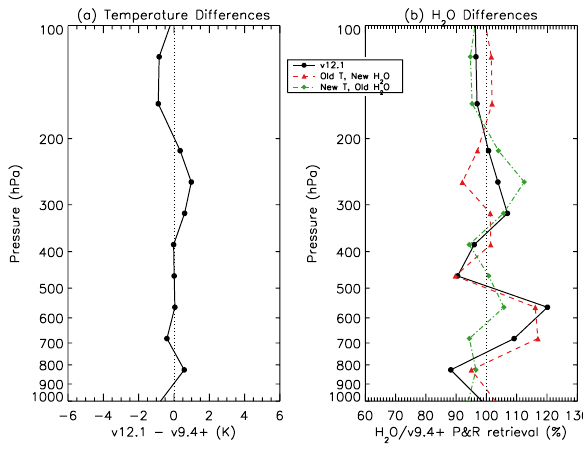
Fig. 21. Mean (black circles) and standard deviation (error bars) of the ratio of the 120 LBLRTM v12.1 retrieved H 2 O profiles to the v9.4 + retrieved profiles, expressed as a percent. Dashed lines show the mean differences for the spectra with 0–2cm (green), 2–4cm (blue), and 4–6cm (orange) PWV. Both models used the P- and R- branches in the retrievals.